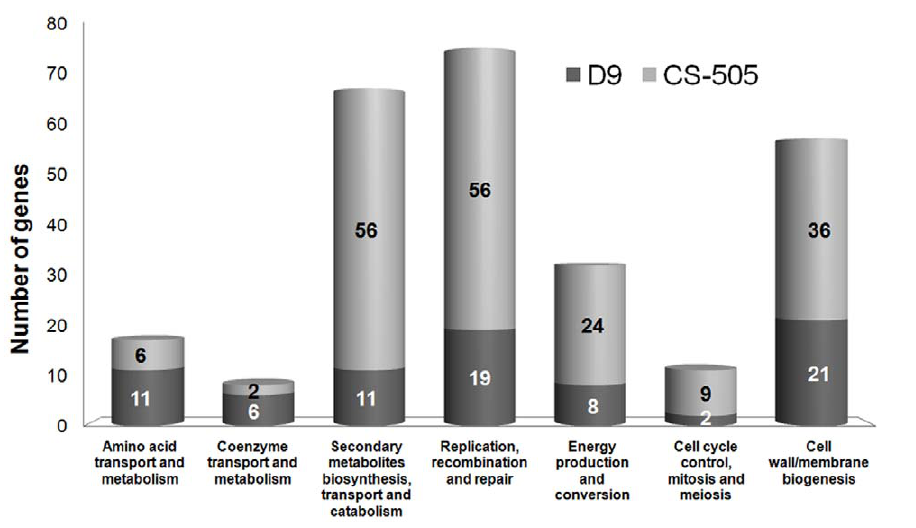
Figure 2. Distribution of the unique CDS of CS-505 and D9 into Cluster of Orthologous Groups (COGs). Only COG categories overrepresented by CDS of CS-505 or D9 are shown (see text for more details). Unique CDS were obtained by a Best-Bidirectional Hits (BBHs) search between both genomes using a 30% cutoff.